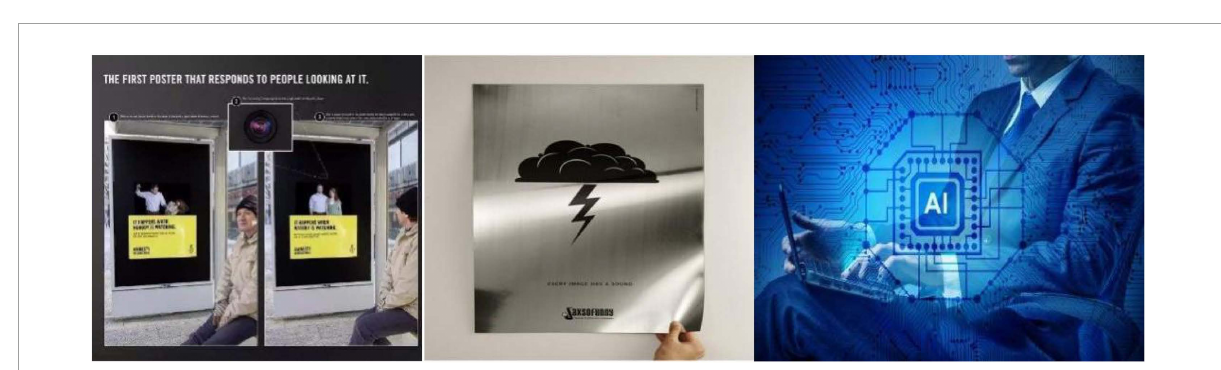
FIGURE1 The changes in online video users.